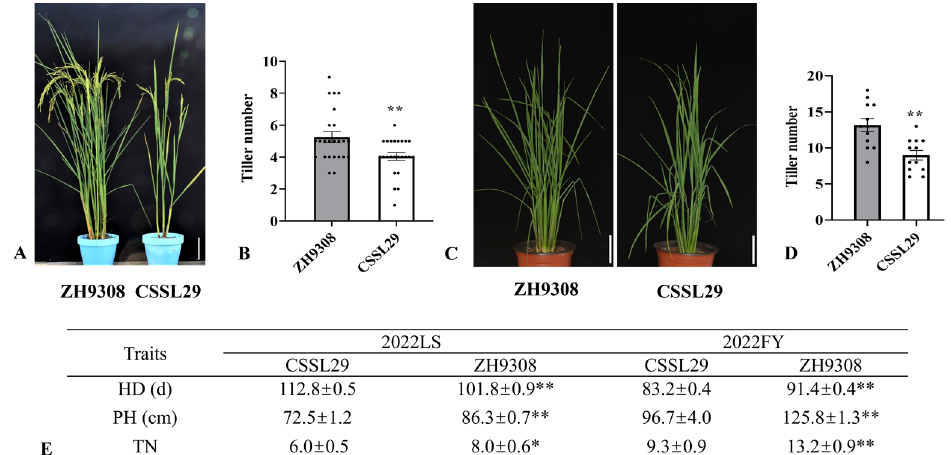
Figure 3. Phenotype of ZH9308 and CSSL29: ( A , B ) the phenotype of ZH9308 and CSSL29 at grain- filling stage in Lingshui in 2021; ( C , D ) phenotype of ZH9308 and CSSL29 at tillering stage in Fuyang in 2022; and ( E ) phenotype of ZH9308 and CSSL29 in Lingshui and Fuyang in 2022. HD, heading date; PH, plant height; TN, tiller number. The CSSL29 was regarded as reference. The scale bar in ( A ) and ( C ) is 10 cm. Data in ( B ) and ( D ) are presented as means ± SEM. n = 24 in ( B ); n = 12 in ( D ). * p < 0.05, ** p < 0.01, Student’s t -test.